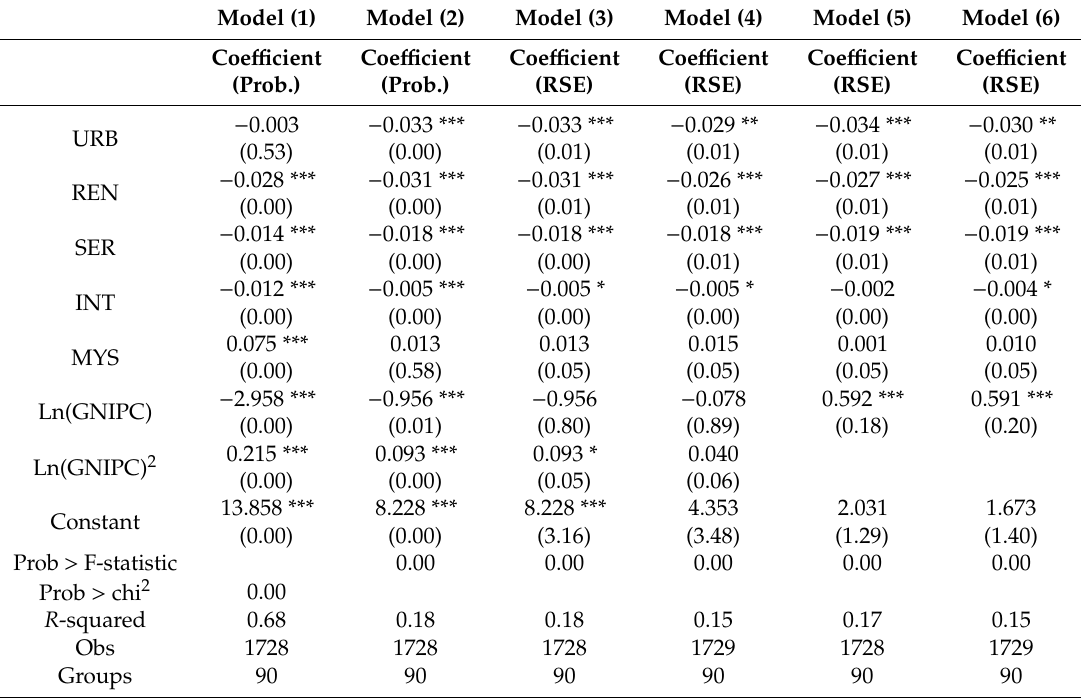
Table 8. Estimations of impacts of influencing factors and control variables for all sample